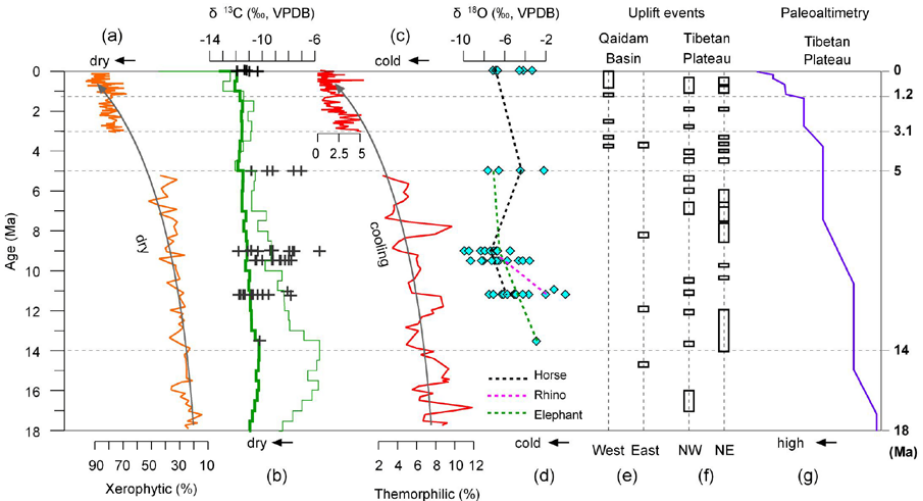
Figure 10. Compiled aridification records in the (a) western (this study) and (b) eastern Qaidam Basin (black cross: δ 13 C records of bulk enamel samples by C. F. Zhang et al. (2012); coarse green line: averaged δ 13 C records of model-predicted values for animals with pure C3 diets by Passey et al. (2009); thin green line at five times the coarse green line), temperature in the (c) western (this study) and (d) eastern Qaidam Basin (blue diamonds: δ 18 O records from bulk enamel samples after C. F. Zhang et al., 2012), tectonic uplift events in (e) the Qaidam Basin (rectangle showing the tectonic events; the western basin after Chang et al., 2012, and W. L. Zhang et al., 2012, 2013; the eastern basin after Fang et al., 2007, and Lu and Xiong, 2009) and (f) the northern Tibetan Plateau (rectangles showing the tectonic events; the NW part after Zheng et al., 2000; Chen et al., 2002; Wang et al., 2003; Sun et al., 2004, 2005, 2007, 2008, 2009; Charreau et al., 2005, 2006; Huang et al., 2006; Heermance et al., 2007, 2008; Sun and Zhang, 2008; Tang et al., 2011, and Zhang and Sun, 2011; the NE part after Li et al., 1997; C. H. Song et al., 2001; Y. G. Song et al., 2001; Zhao et al., 2001; Fang et al., 2003, 2005a, b; Pares et al., 2003; Zheng et al., 2006; Lin et al., 2010; Wang et al., 2010; and W. T. Wang et al., 2011; X. X. Wang et al., 2011), and (g) the presumed paleoaltimetry history after An et al. (2006).